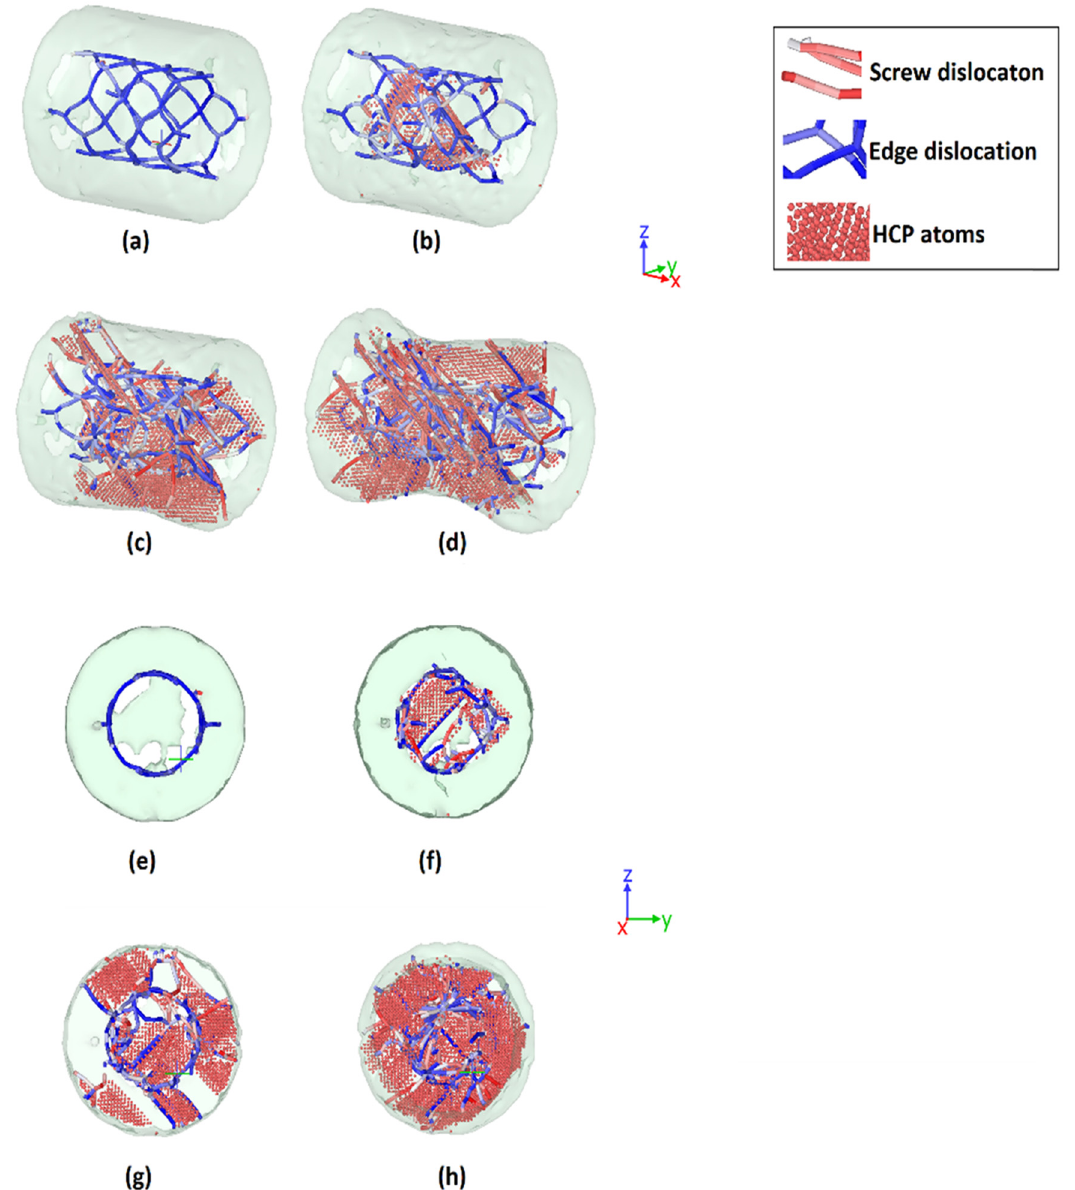
Figure 6: DXA analysis results presenting the dislocation density and stacking fault areas in Ni – Al core – shell nanowire at the di ff erent strains. ( a ) ε = 0, ( b ) ε = 0.08, ( c ) ε = 0.15, ( d ) ε = 0.25, and ( e – h ) the other views at the same